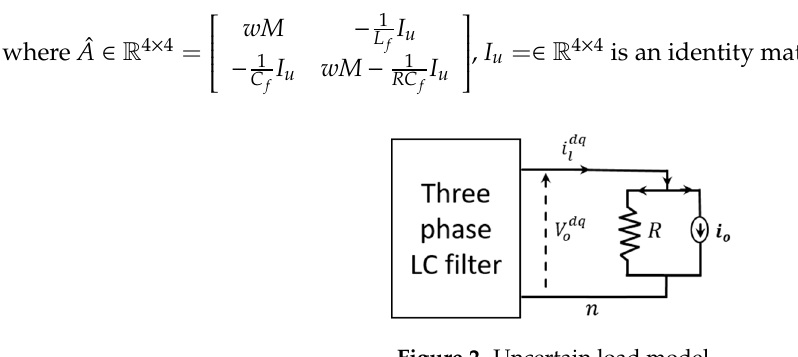
Figure 2. Uncertain load model.